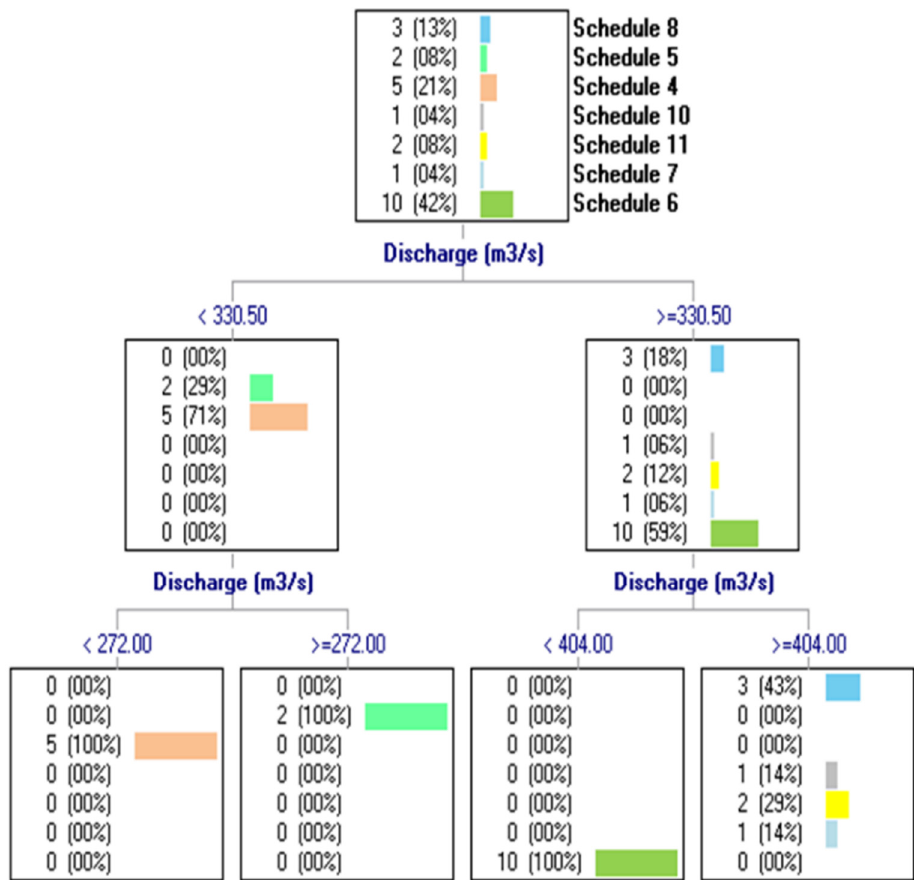
Figure 10. Decision tree by using the ID3 algorithm Tianshengqiao plant 2 for the summer season.